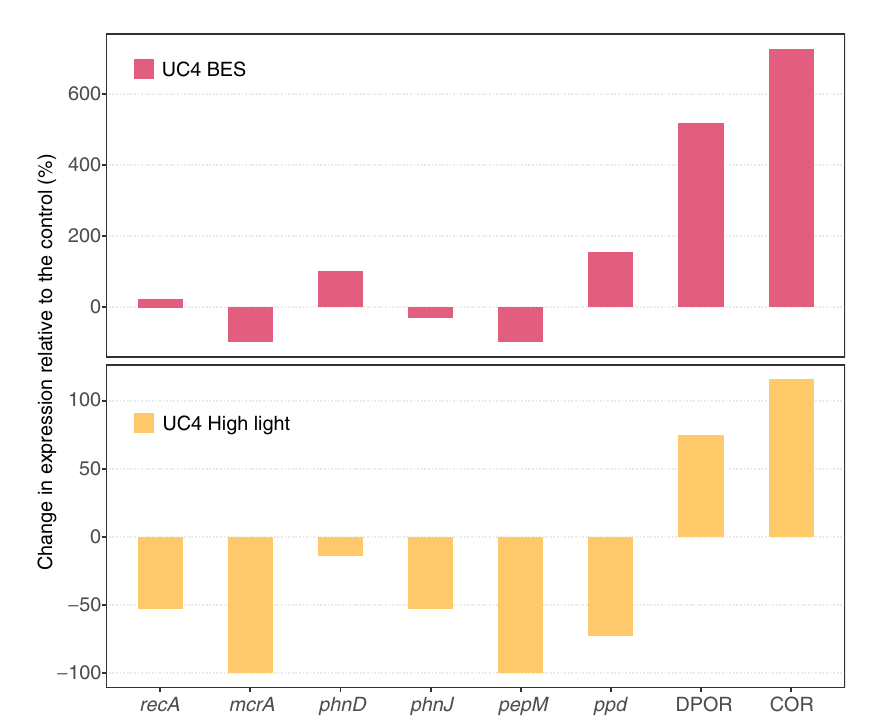
Fig. 4 | Gene expression in the UC4 experimental treatments compared with the control. Functional genes involved in methanogenesis (methyl coenzyme M reductase; mcrA ),phosphonateassimilation(phosphonate-bindingproteinandC-P lyase; phnD and phnJ ), phosphonate synthesis (phosphoenolpyruvate mutase and phosphonopyruvatedecarboxylase; pepM and ppd ),andporphyrinandchlorophyll metabolism (ferredoxin:protochlorophyllide reductase and chlorophyllide